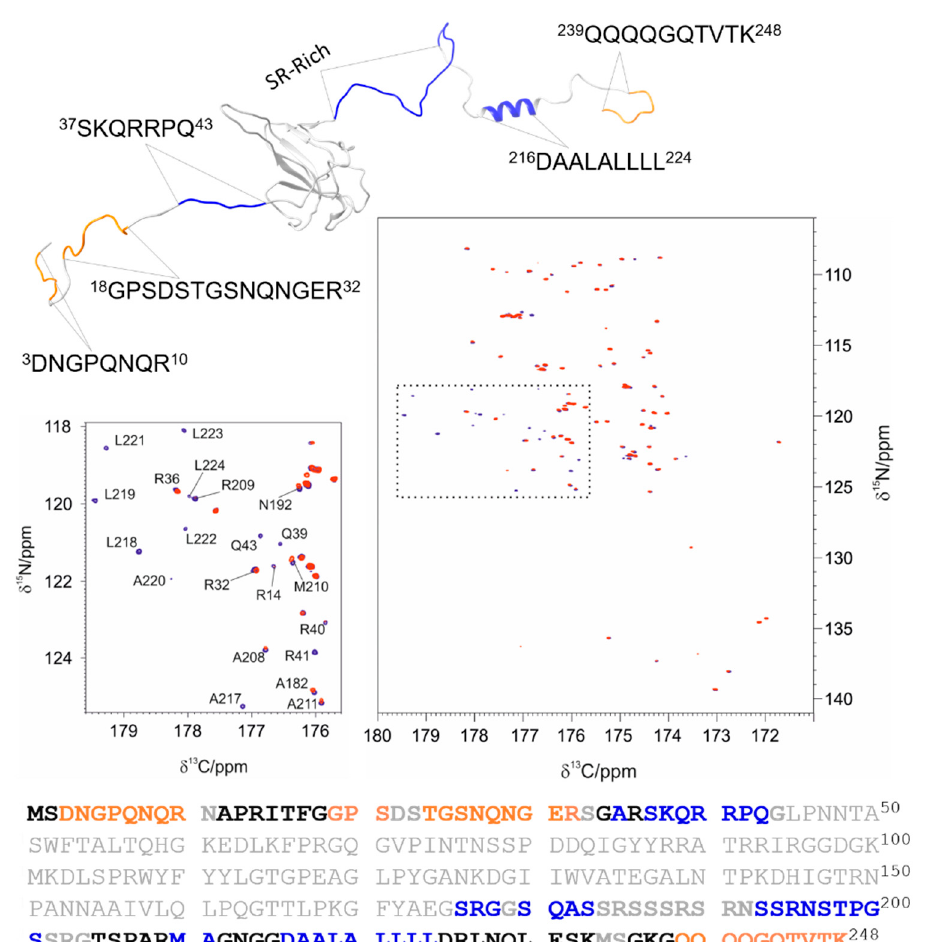
Figure 10. The picture reports the superimposition of the two CON spectra of NTR: the spectrum before the addition of EP (blue) and the one acquired after the addition of 0.3 equivalents of EP (red). The positively charged regions of the protein and the poly-Leu region are found to be the most affected by the interaction. This is highlighted in the expansion reported on the left, where the cross peaks from nuclei in the stretches 36-43, 208-211, and 216-224 are shown. A structural model of NTR is reported in the upper part of the figure and the primary sequence of the protein in the lower part. The IDRs are reported in bold, and the following color coding has been used to highlight the different behavior of specific tracts: the residues that are still observable at the end of the titration are reported in orange, while the residues that show a variation in chemical shift and/or a reduction in intensity are reported in